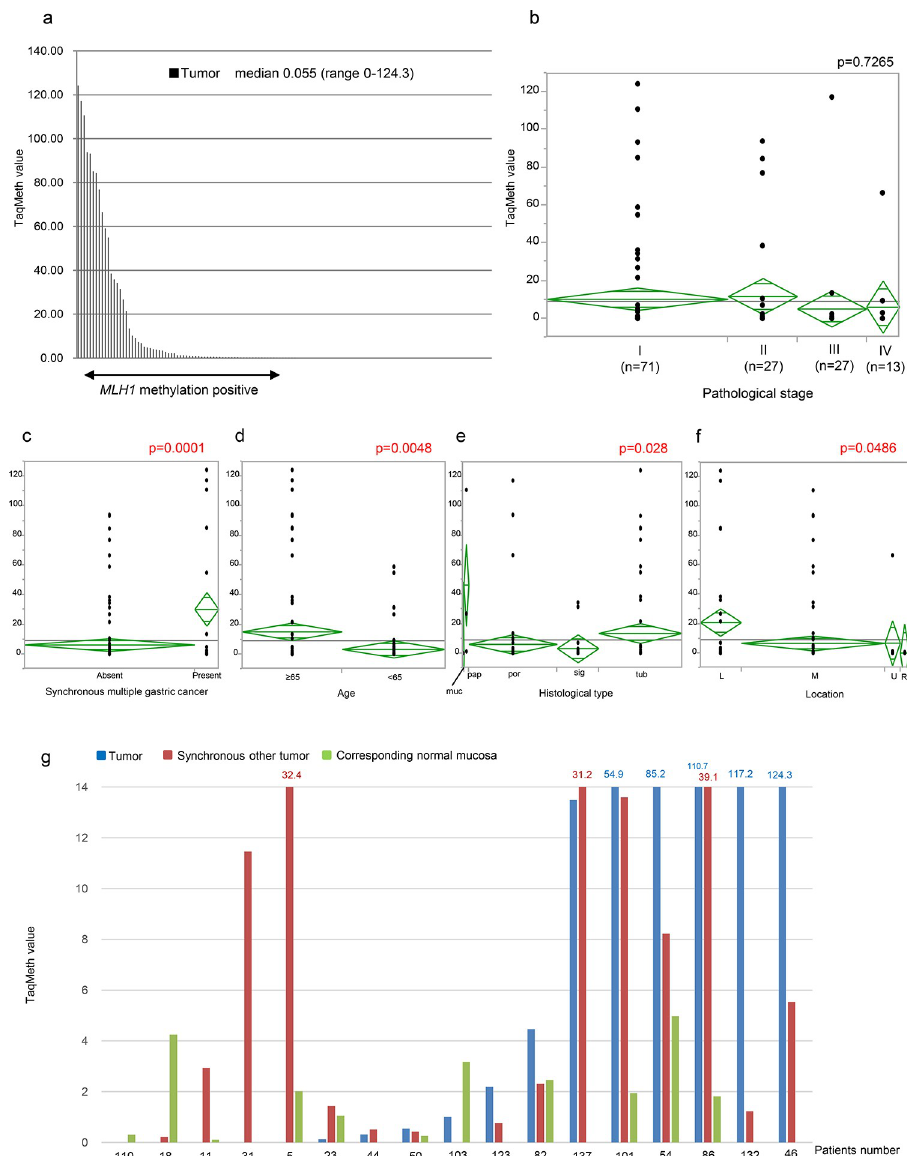
Fig 2. MLH1 TaqMeth value in primary gastric cancer and its correlation with clinicopathological factor. (a) MLH1 TaqMeth value distribution in the gastric cancer tissues. Median TaqMeth value of MLH1 was 0.055, ranging from 0 to 124.3. MLH1 TaqMeth value distribution in the gastric cancer tissues according to (b) Pathological stage, (c) Synchronous multiple gastric cancer, (d) Age, (e) Histological type, (f) Tumor location. (g) MLH1 TaqMeth value in the corresponding non-cancerous gastric mucosa tissues, cancerous tissue and synchronous other tumor tissue. Abbreviation: muc; Mucinous adenocarcinoma, pap; Papillary adenocarcinoma, por; Poorly differentiated adenocarcinoma, sig; Signet-ring cell carcinoma, tub; Tubular adenocarcinoma, L; Lower site, M; Middle site, U; Upper site, R; Residual gastric